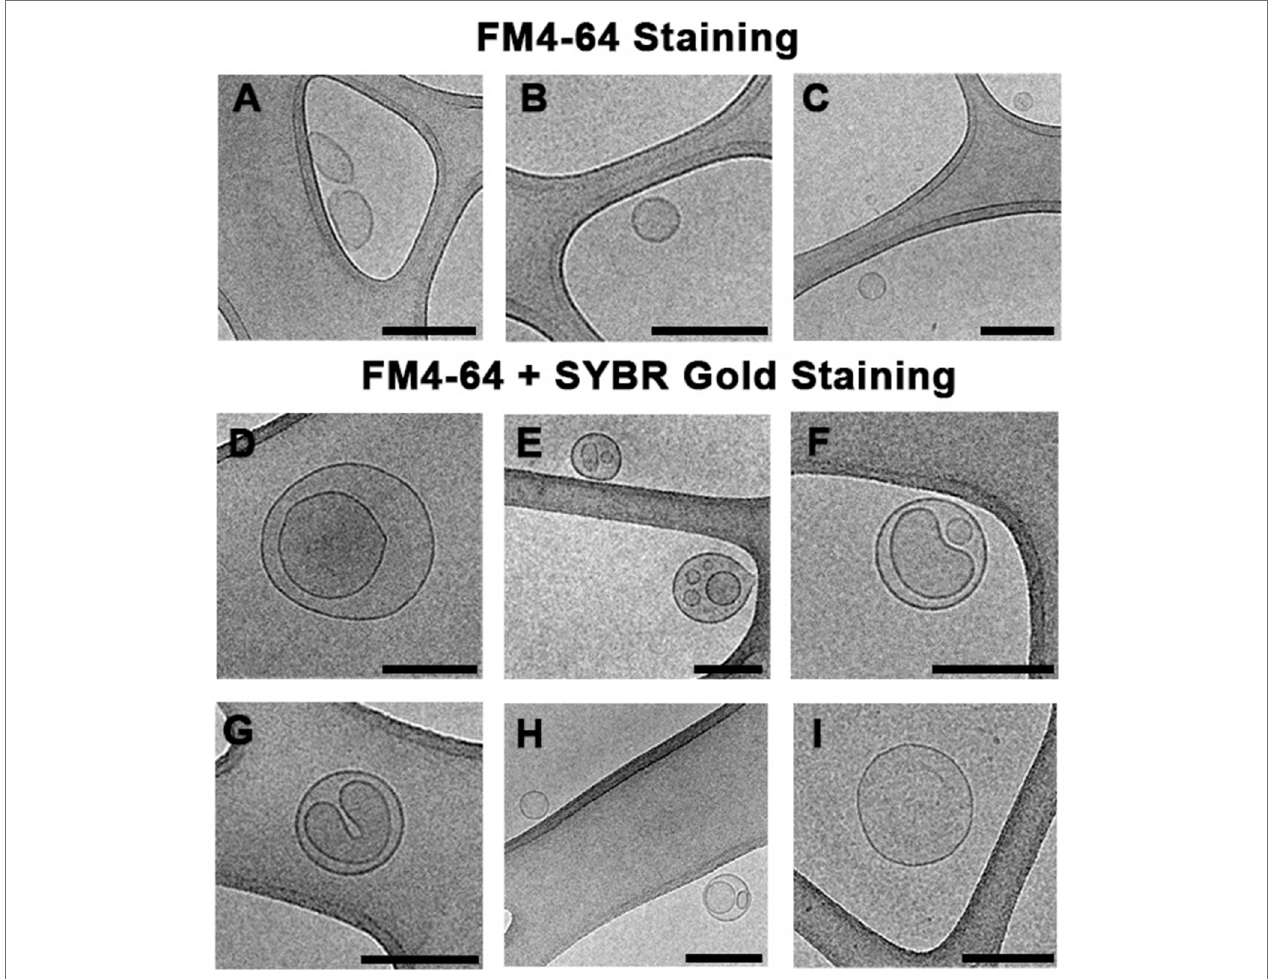
FIGURE 6 | Cryo-electron microscopy images of MVs from S. vesiculosa M7 T separated by flow cytometry sorting. MVs were isolated from TSB liquid cultures of S. vesiculosa M7 T at 24 h of incubation and were submitted to sorting by flow cytometry. Cytometry events were separated into two channels. Events marked only with FM4-64 were collected in one channel, and events marked with FM4-64 and SYBR ™ Gold in another one. Subsequently, they were ultracentrifuged and cryofixed by Plunge Freezing. The images are representative of the different types of MVs observed by Cryo-EM. Images (A–C) show that events labeled with only FM4-64 corresponded mostly (90%) to single-layered MVs probably corresponding to OMVs. Images (D–I) show events marked with both fluorochromes and corresponded predominantly to double-layered MVs (70%); some of them have the same structure described for outer-inner membrane vesicles (D) , while others showed strange shapes with an external layer and more than one vesicle inside (E–H) . A lower percentage of MVs (30%) marked with both fluorochromes were visualized as one-layered MVs (I) . Bars, 200